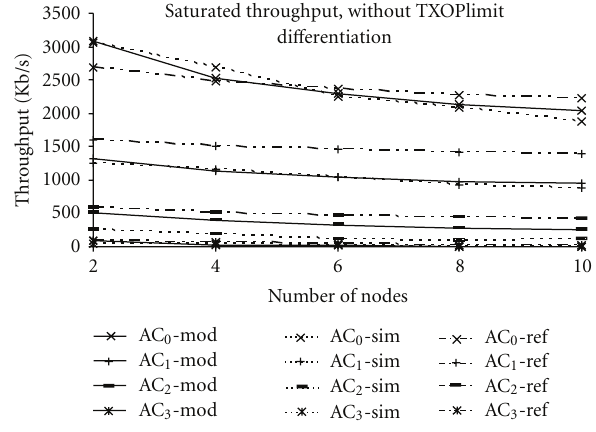
Figure 14: Throughput per AC, without TXOP.